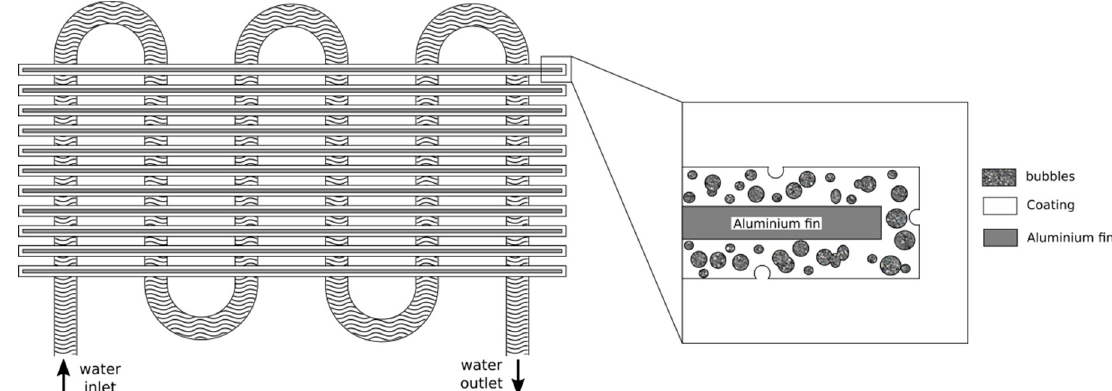
Figure 6. Scheme of plate heat exchanger coated with a flexible and porous coating.